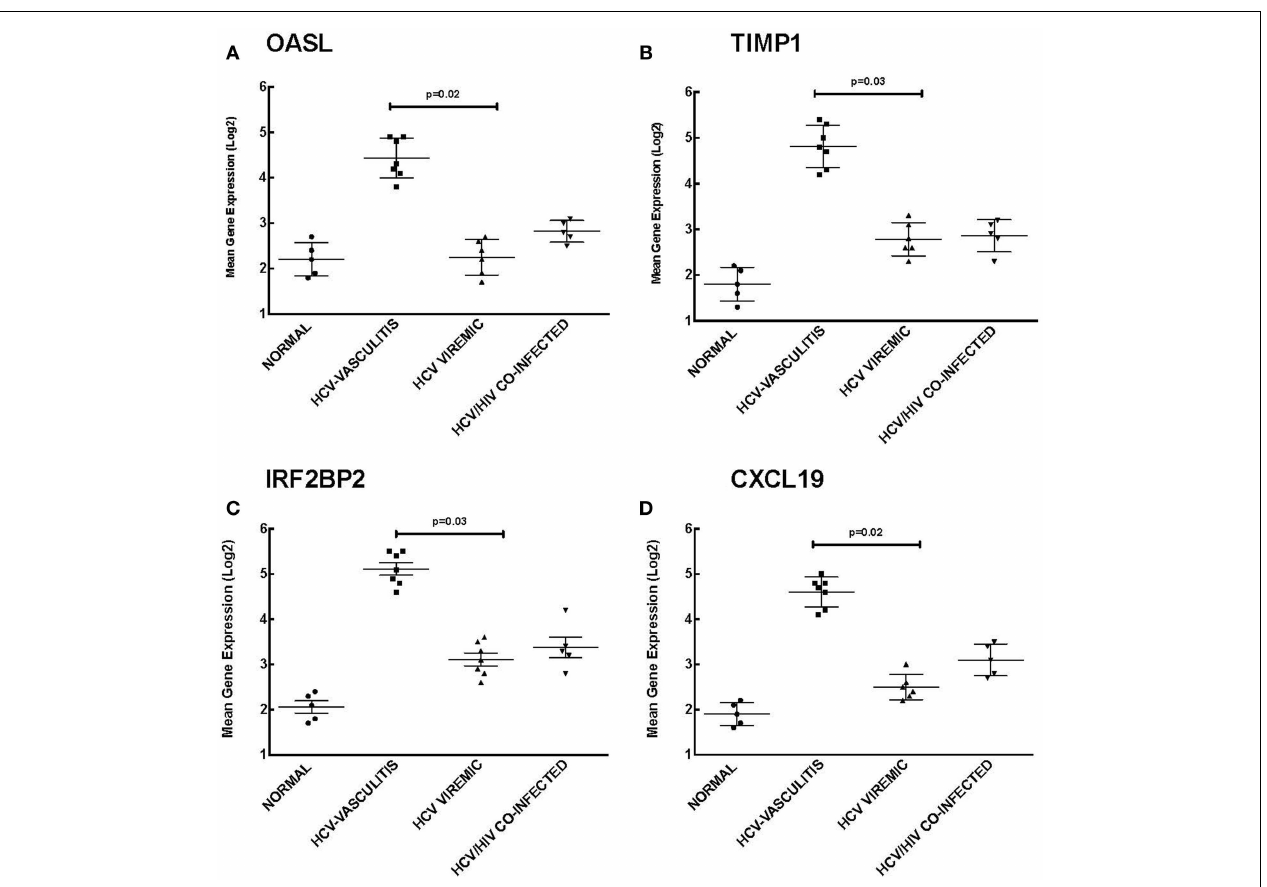
GAPDH. The expression of OASL (A) ,TIMP1 (B) , IRF2BP2 (C) , and CXCL16 (D) was up-regulated in the HCV MC vasculitis cohort compared to the other groups ( p = 0.02, 0.03, 0.03, and 0.02, respectively between HCV MC-Vasc and HCV